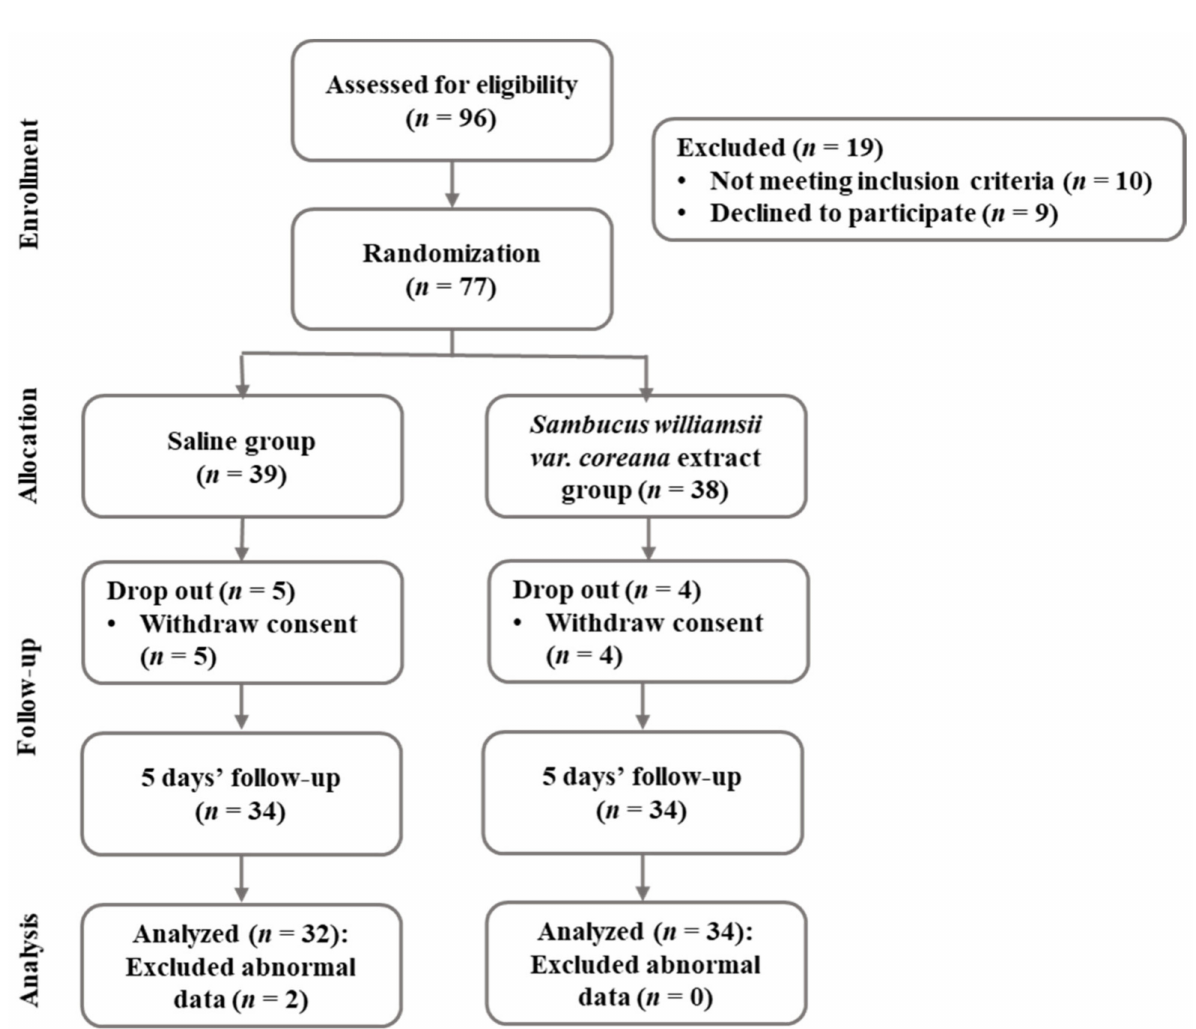
Figure 1. Flowchart of the research